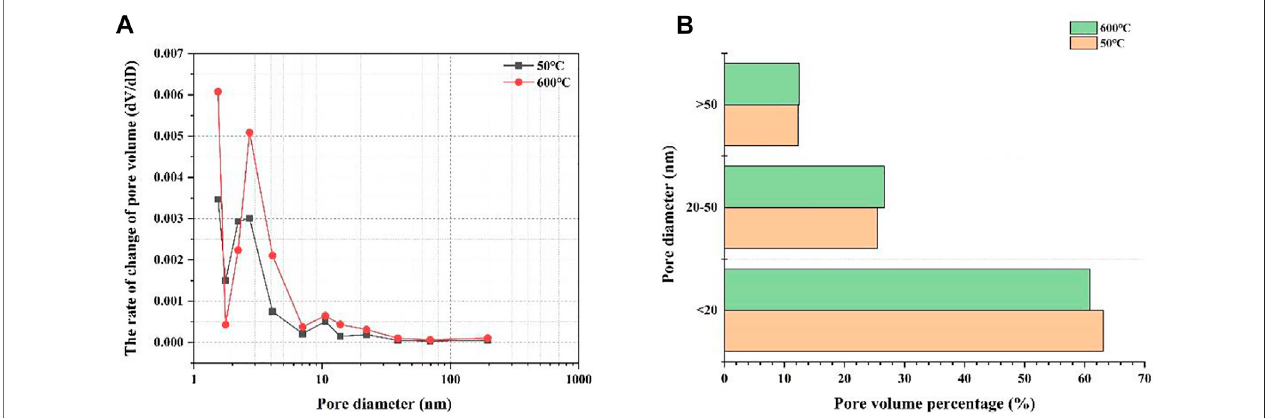
FIGURE 7 | Pore size distribution curve (A) and histogram (B) of C1 cement paste after curing at 50 and 600 ° C.